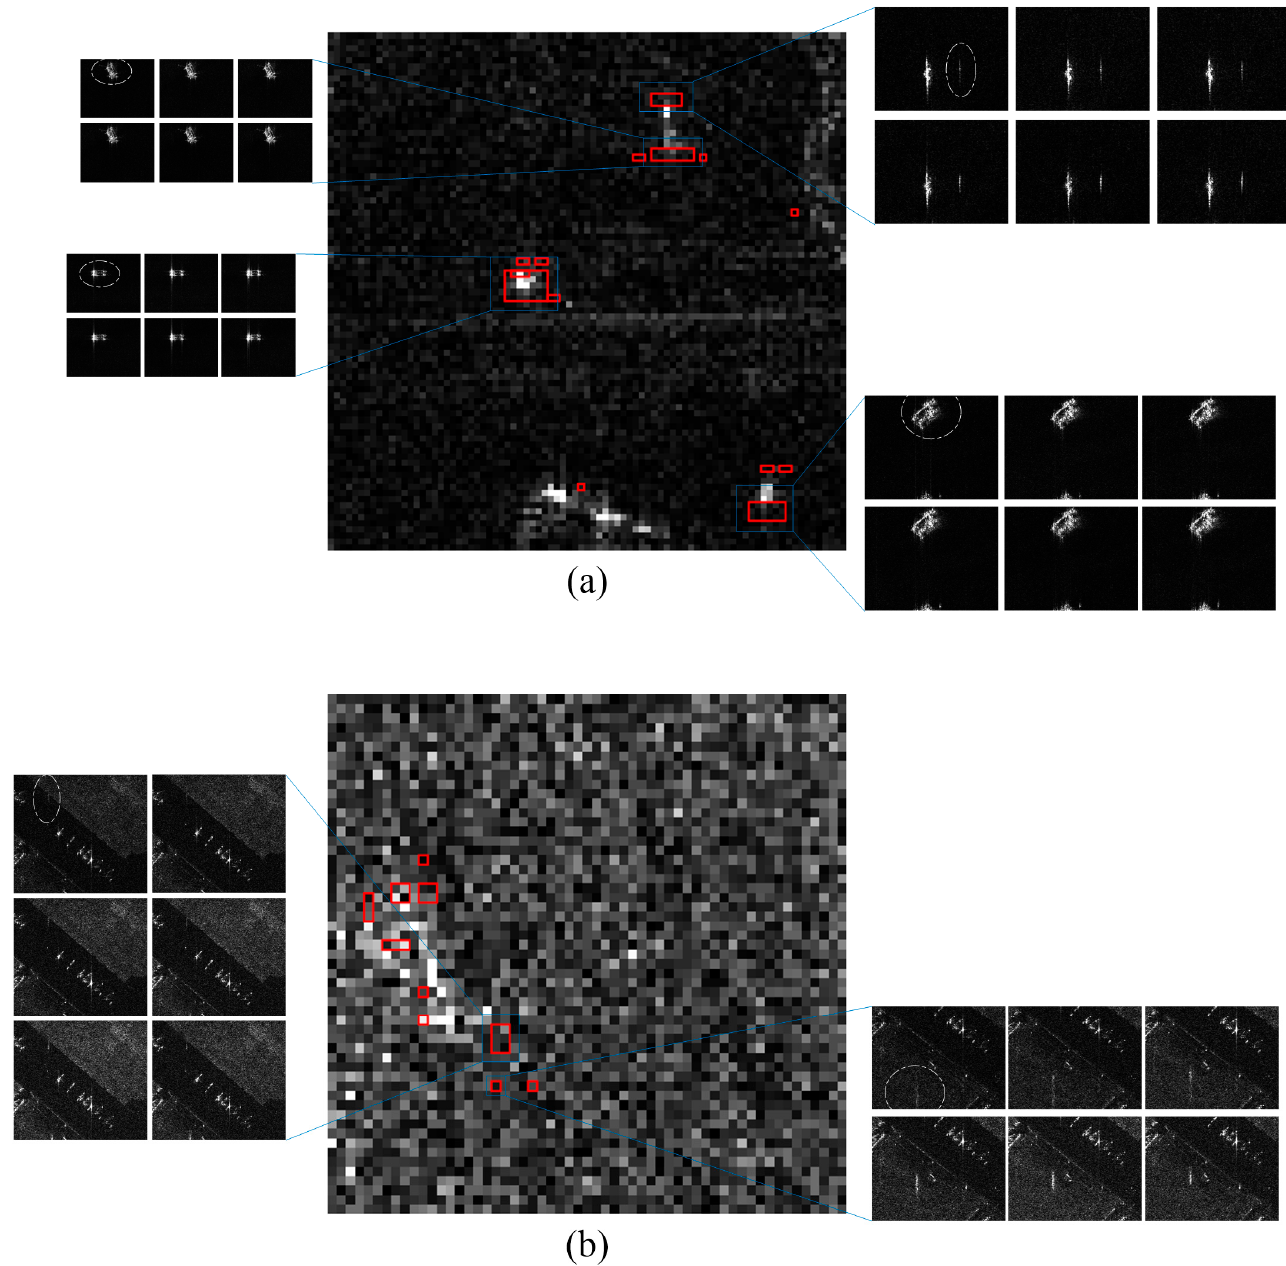
Figure 7a. In Figure 7d, multiple proximal vehicle signals are observed along farm ridges. In addition to the moving targets detected and areas difficult to visually perceive and confirm, there are false alarms indicated from sea–land junction areas (including small islands) and around the suburban buildings or infrastructure. Empirically, it is evident that a large number of these man-made features could generally degrade the phase-related Gaussian approximations. Hence, for the red squares whose coverage is larger than the number of looks, they should be eliminated. However, in practice, these results may have no meaning for homogenous-area surveillance tasks because a land-avoidance strategy can also be